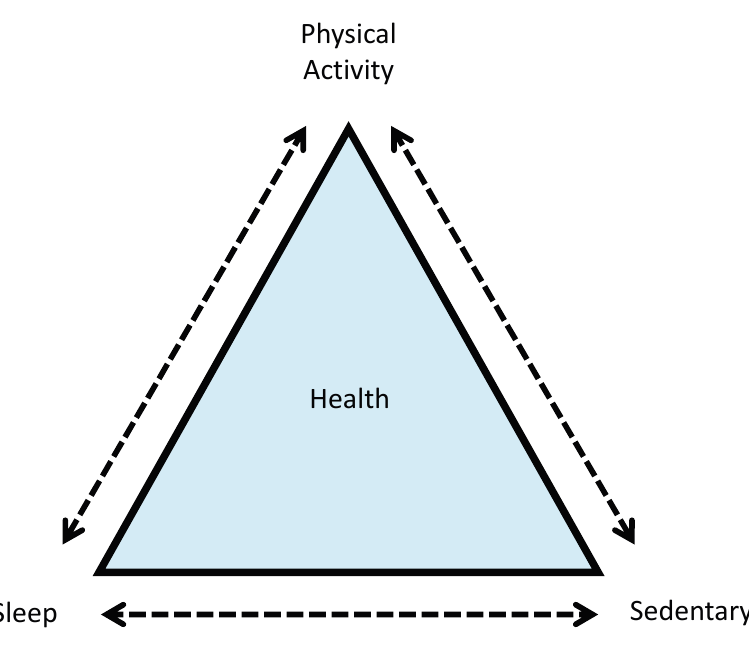
Figure 2. Interactions between movement and non-movement behaviors to collectively impact